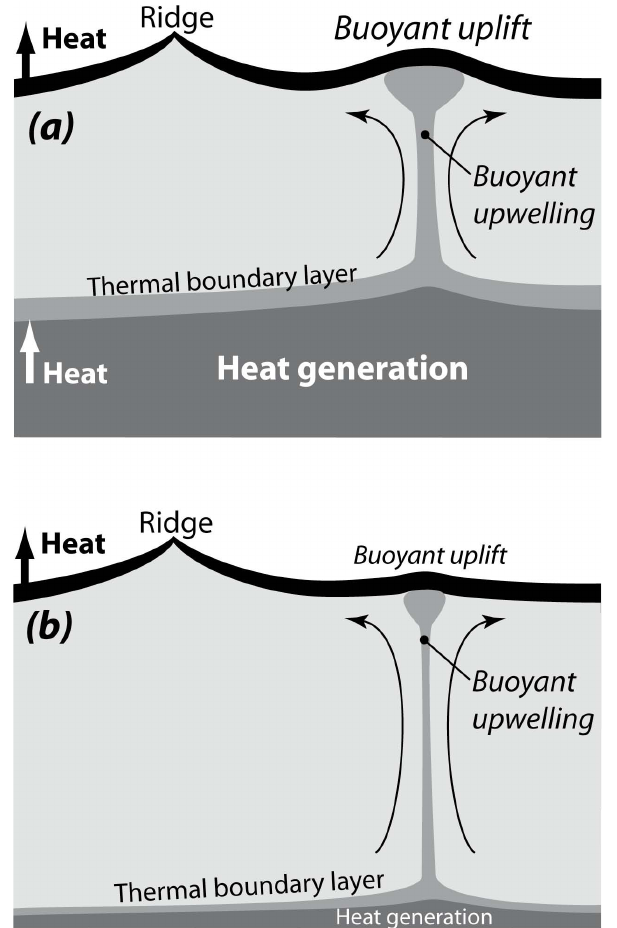
Fig. 22. Sketches of relationship between heating and topography. (a) A thick lower layer supplies strong heating to the base of the upper layer, generating a strong buoyant upwelling and large to- pography. (b) A thin layer supplies only a small amount of heat, generating a weaker upwelling and small